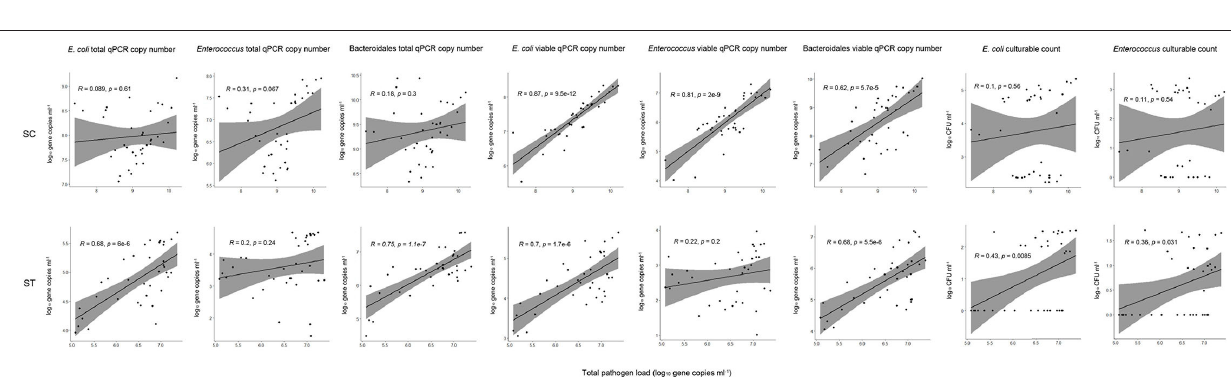
FIGURE 5 | Pearson correlations between total pathogen loads and fecal indicator bacteria with different measurement strategies. The culturable plate counts, total and viable qPCR gene copies of E. coli , Enterococcus, and Bacteroidales were compared to the total pathogen loads (all viable pathogens) for all samples collected before and after chlorine disinfection throughout the year in each sewage treatment